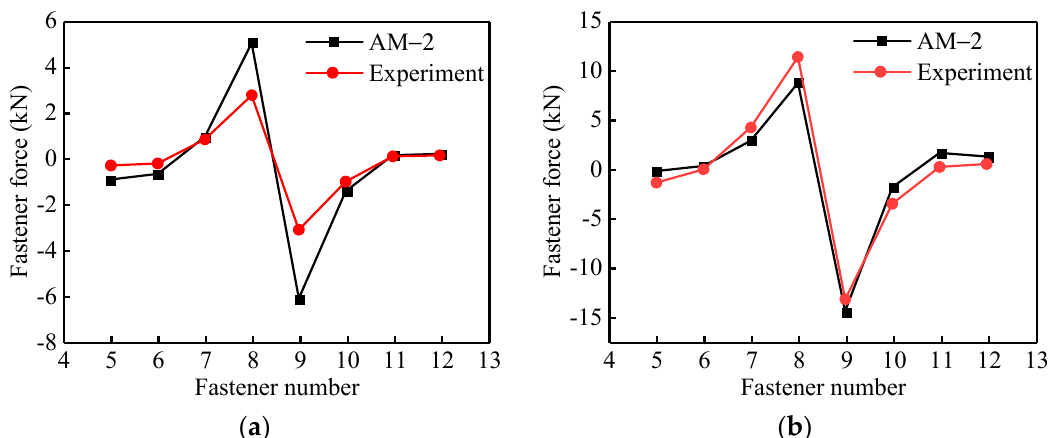
Figure 6. Comparison of theoretical results and experimental results of fastener forces: ( a ) 1# girder vertical fault 0.5 mm; ( b ) 1# girder vertical fault 2.5 mm.